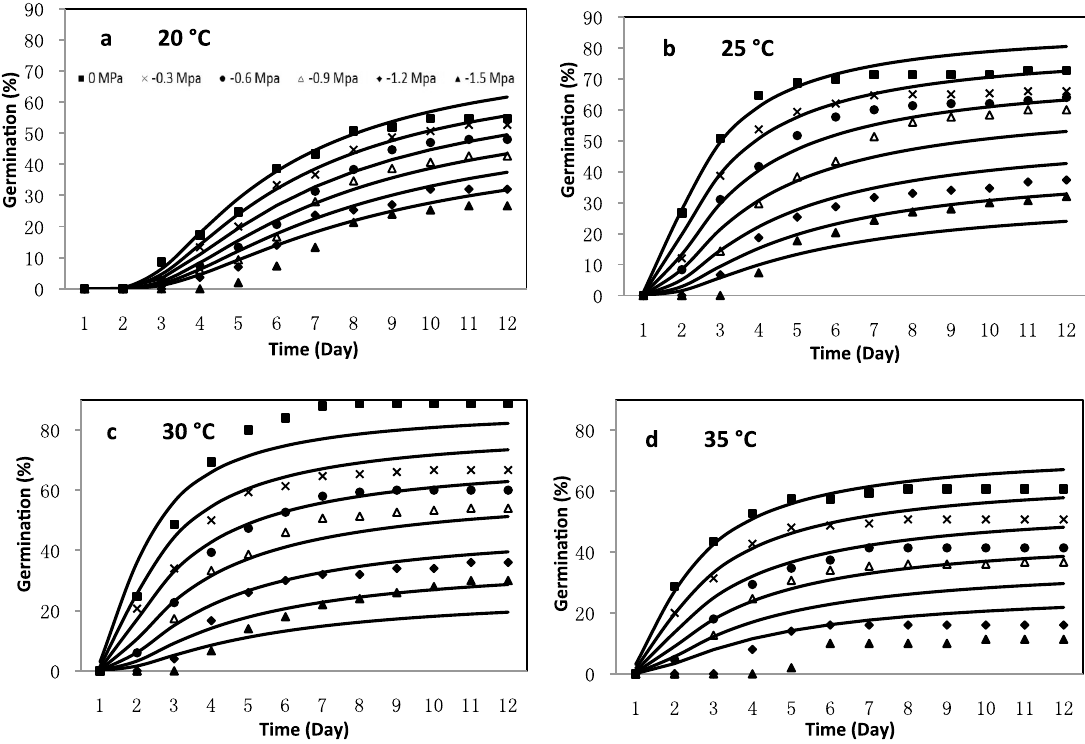
Fig. 2: Germination time course of A. venetum seeds for a range of water potentials at various constant temperatures. Symbols indicate actual data, and lines indicate values predicted by probit